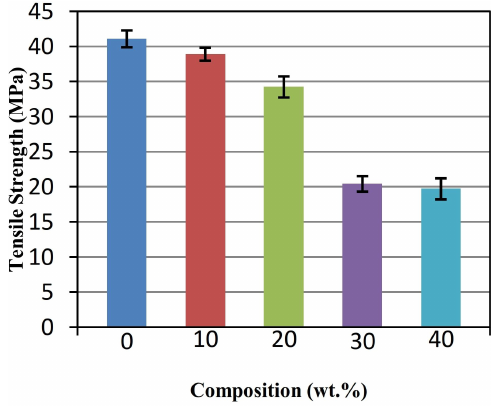
Figure 7: Variation of flexural strength with the filler content [39]